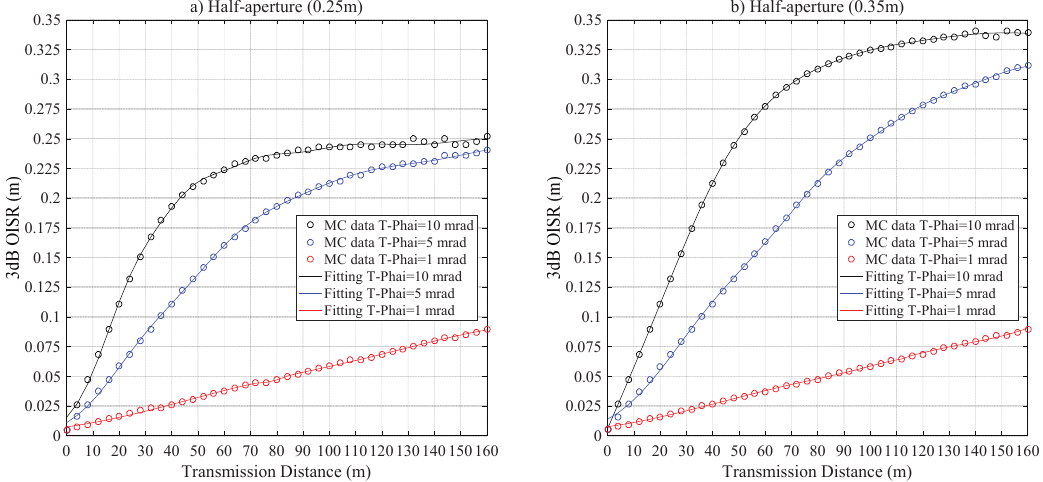
Figure 5. The r 3 dB versus Z 0 for pure seawater laser channel for a half-aperture of ( a ) R PD = 0.25m and ( b ) R PD = 0.35